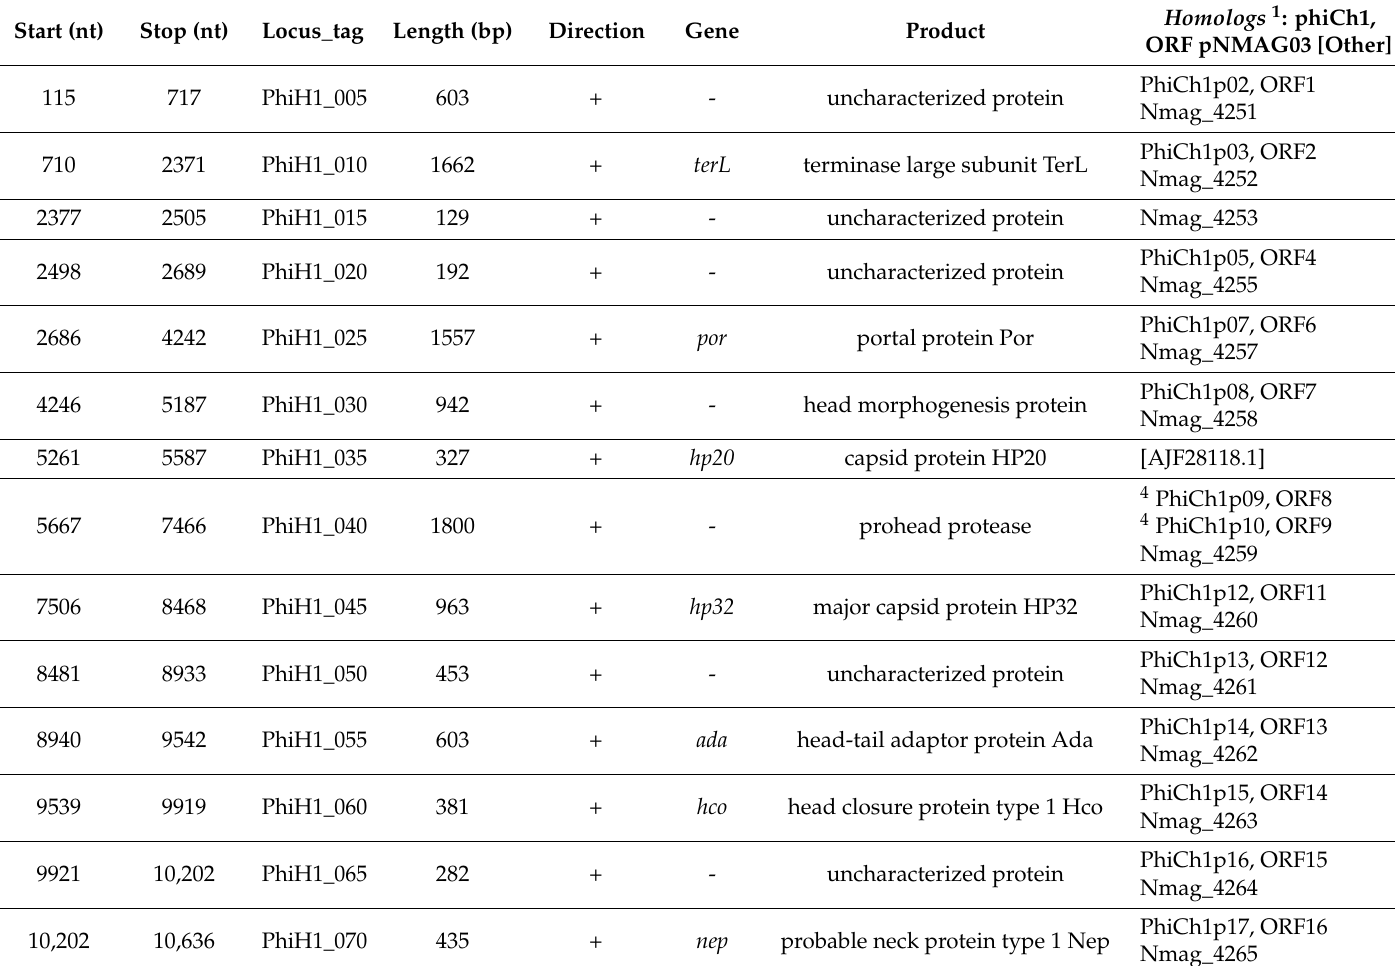
Table 1. Annotated coding sequences (CDS) of halovirus